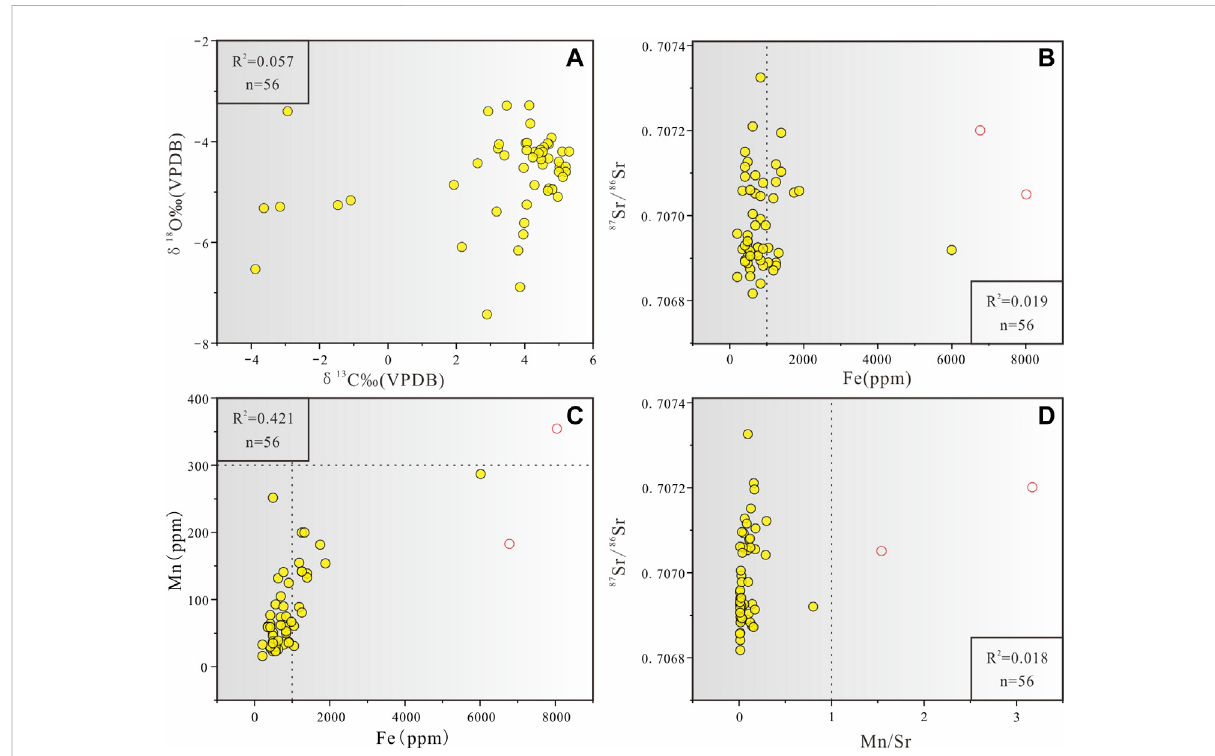
FIGURE 6 Scatter diagrams showing correlations of (A) δ 13 C carb with δ 18 O, (B) Fe with 87 Sr/ 86 Sr, (C) Fe with Mn, and (D) Mn/Sr with 87 Sr/ 86 Sr in the investigated Dukou section (Red rings indicate data may have been affected by